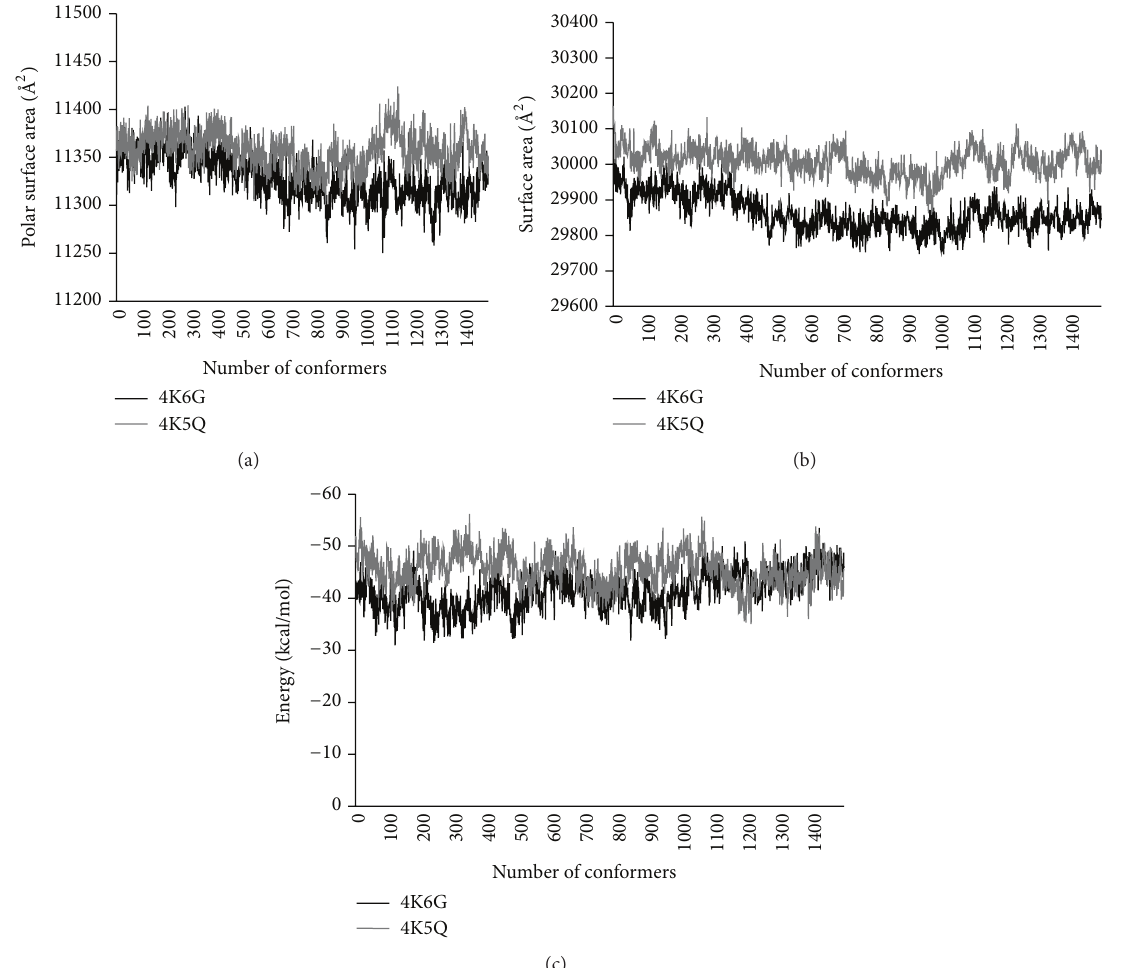
Figure 2: Geometrical observables of native (4K6G) CALB and mutant (4K5Q) CALB. (a) Polar surface area. (b) Surface area. (c) Energy levels calibrated by knowledge-based